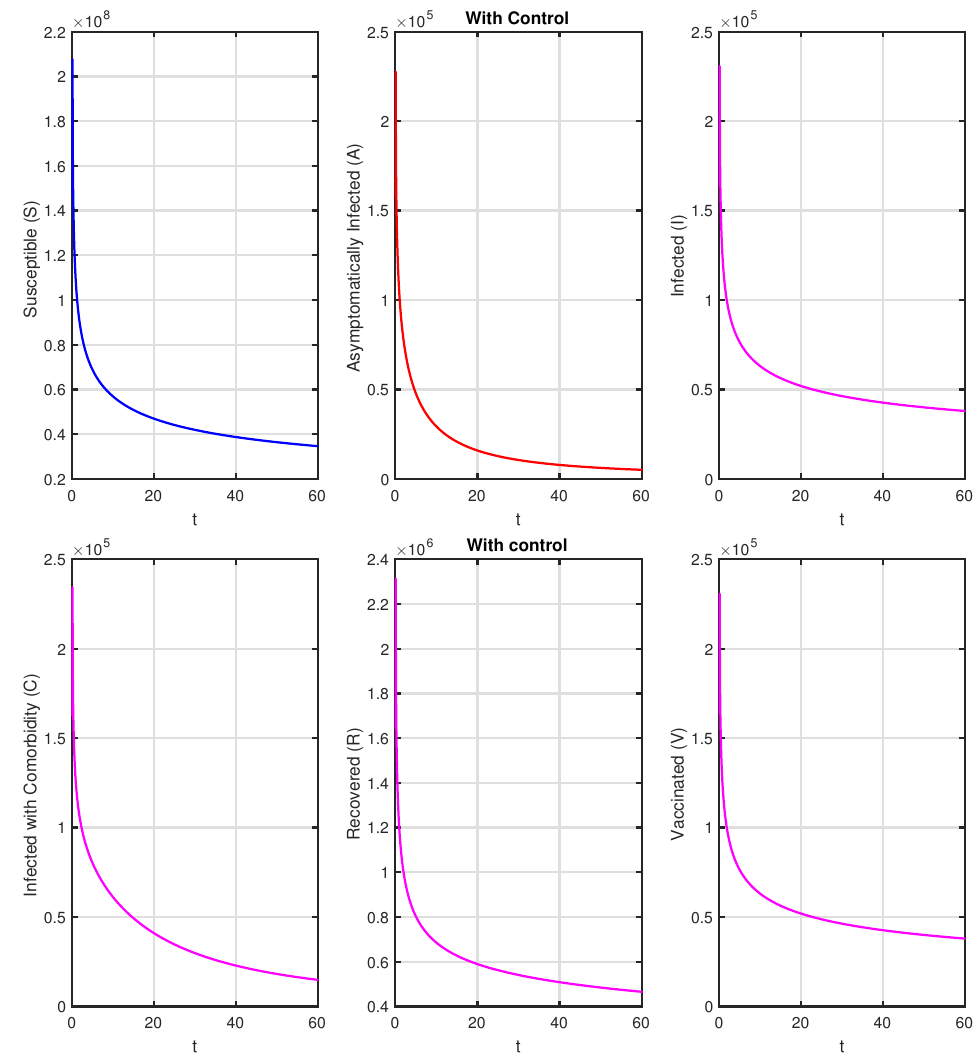
Figure 5. Time series of state variables when combined control strategy is